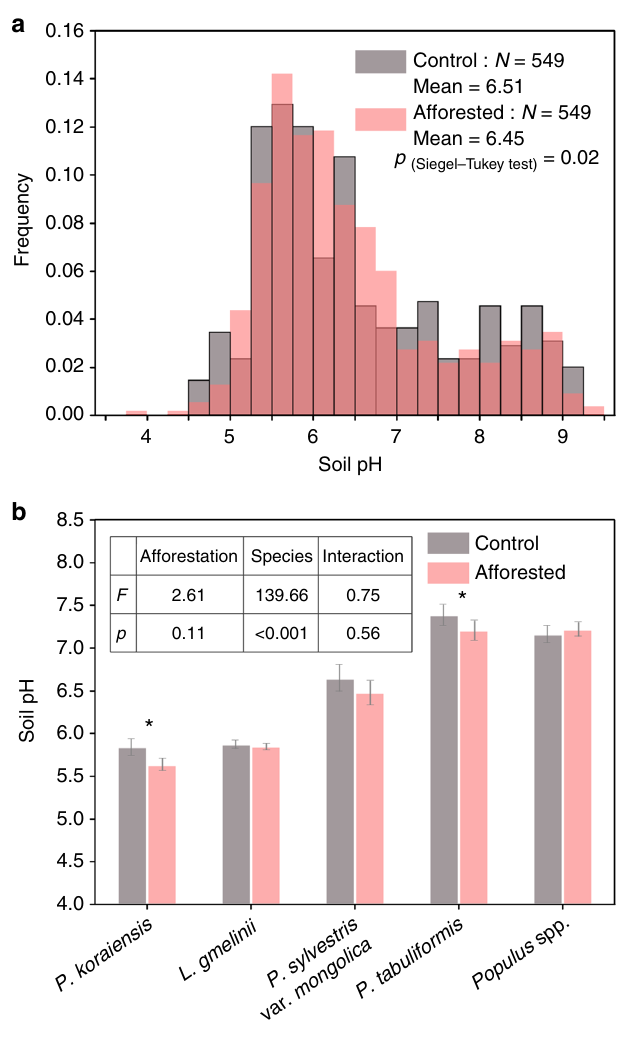
Fig. 2 Comparison of soil pH in control and afforested groups. a The frequency distribution of soil pH in control and afforested groups. Siegel − Tukey test was used to compare the frequency distributions of soil pH between the control and afforested groups. b Soil pH for the control and afforested groups across fi ve tree species. Error bars indicate standard errors. * indicates 0.01 < p < 0.05, ** indicates 0.001 < p < 0.01, and *** indicates p < 0.001 from paired t -test. The inset shows the results of two- way ANOVA on the effect of afforestation (control vs. afforested) and species on soil pH. Interaction indicates afforestation × species